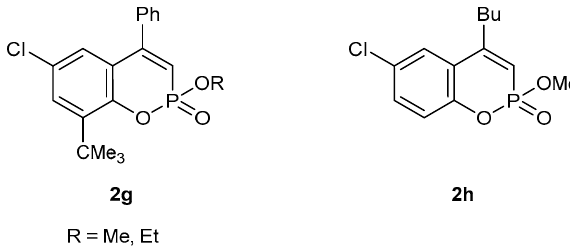
Figure 8. The structures of obtained 1,2-benzophosphorins of type 2 .